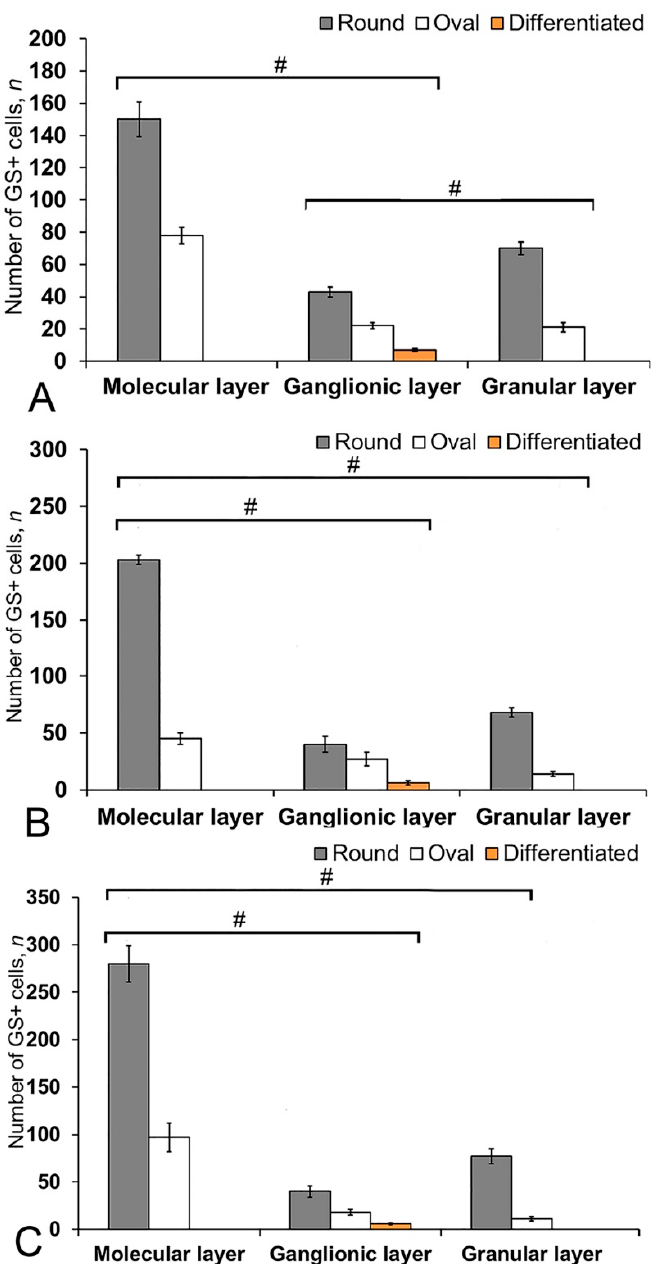
Figure 6. The number of GS+ cells in the intact cerebellum of juvenile masu salmon, Oncorhynchus masou . ( A ) Dorsal zone. ( B ) Lateral zone. ( C ) Basal zone. Gray columns are type 1 cells; white, type 2 cells; orange, type 3 cells. #— significant differences ( p ≤ 0.05) between molecular/ganglionic layers and ganglionic/granular layers ( A ), molecular/ganglionic layers and molecular/granular layers ( B , C , n = 5 in each group; # are significant intergroup differences); one-way analysis of variance (ANOVA). The cerebellum layers of juvenile masu salmon, O. masou , are plotted on the